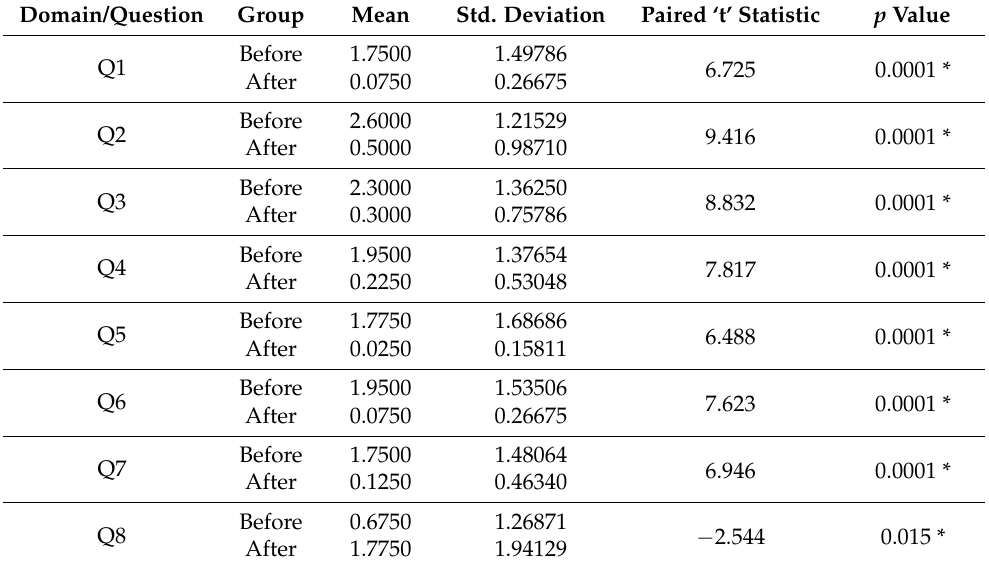
Table 4. Comparative evaluation of quality of life before and after treatment in Group 2— Rotational Technique.